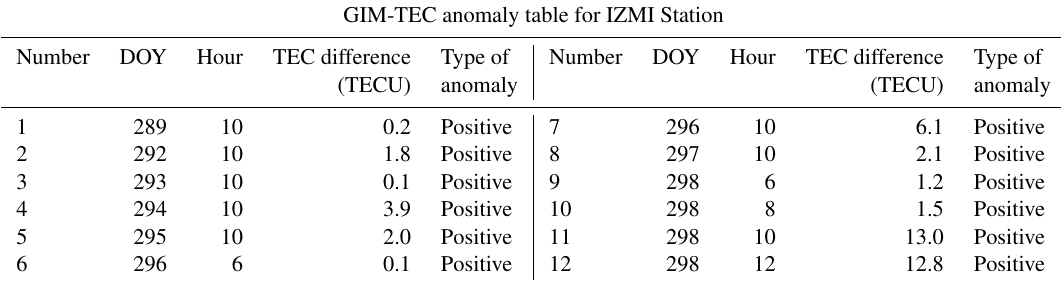
GIM-TEC anomaly table for IZMI Station